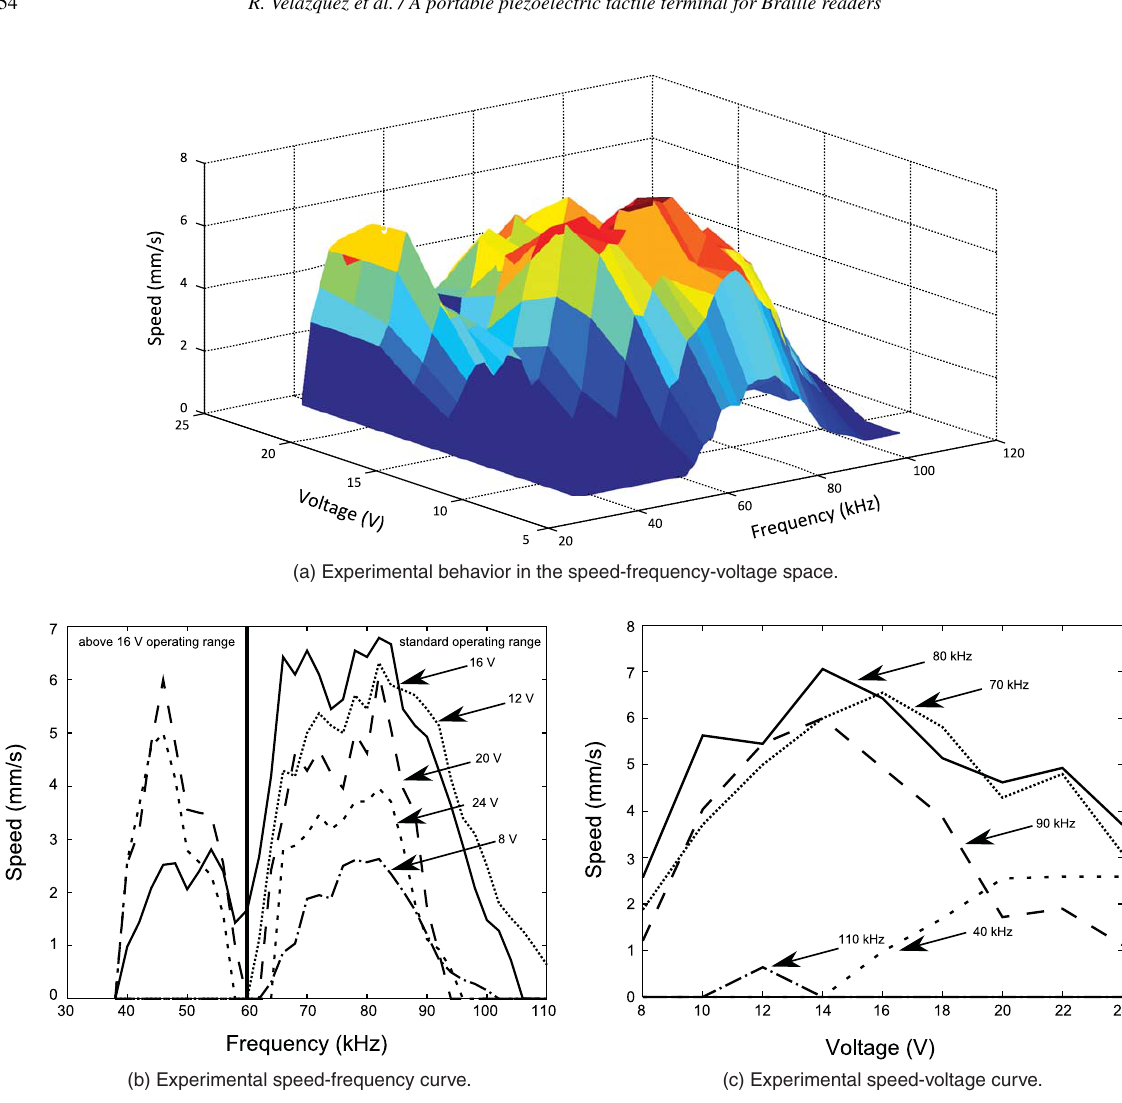
Fig. 10. Experimental relations for the piezoelectric